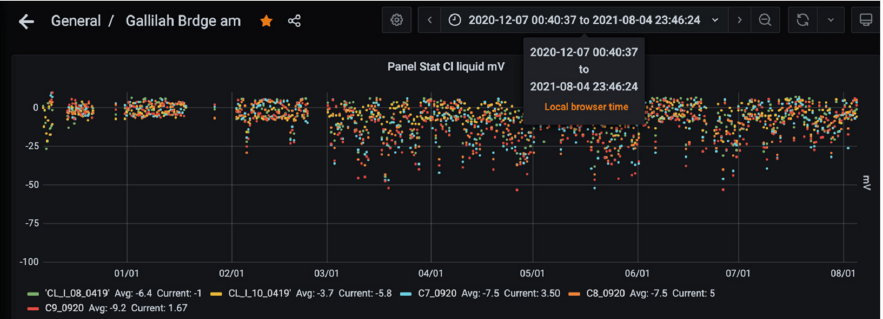
Figure 16. Graphana dashboard for real-time data visualization: chloride concentration in the monitored concrete